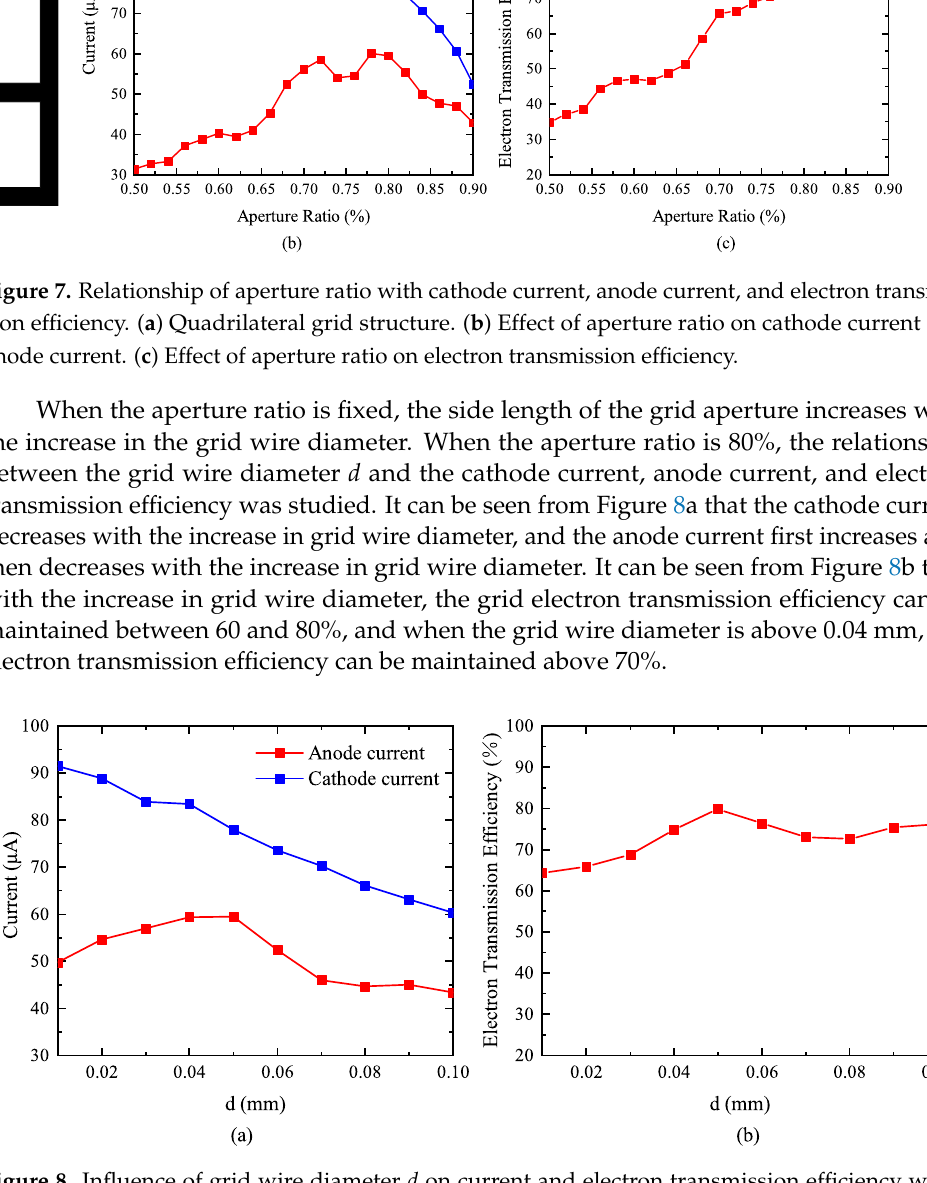
Figure 8. Influence of grid wire diameter d on current and electron transmission efficiency when aperture ratio is 80%. ( a ) Effect of grid wire diameter d on current at aperture ratio of 80%. ( b ) Effect of grid wire diameter d on electron transmission efficiency at aperture ratio of